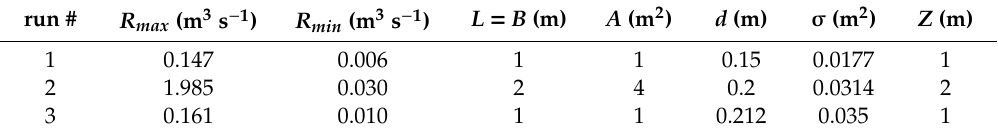
Table4. Forthethreeruns, runo ff dischargeranges, R max and R min ,